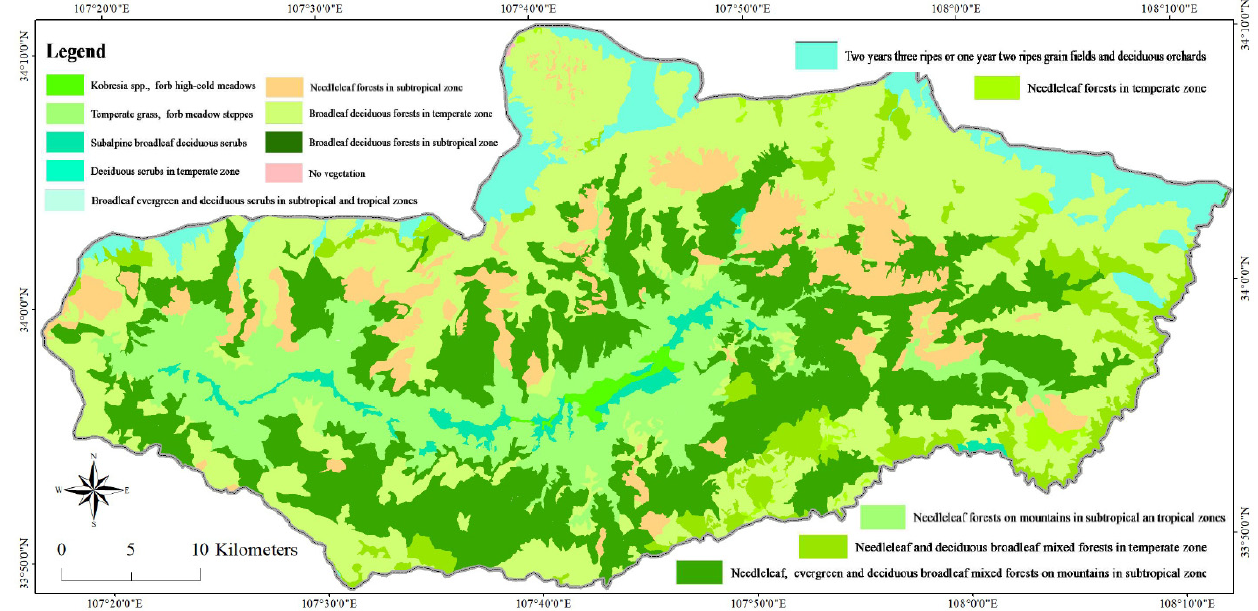
Figure 7. A 1:500,000 vegetation type map of Taibai Mountain from historical interpretation. Table 2. Ranges of elevation values for different vegetation groups in Taibai Mountain.